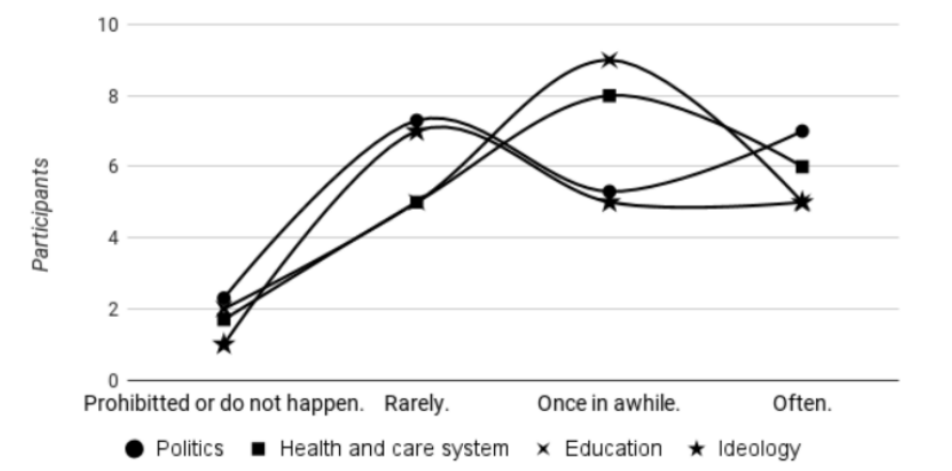
Figure 6. Frequency of posts dealing with politics, health and care system, education and